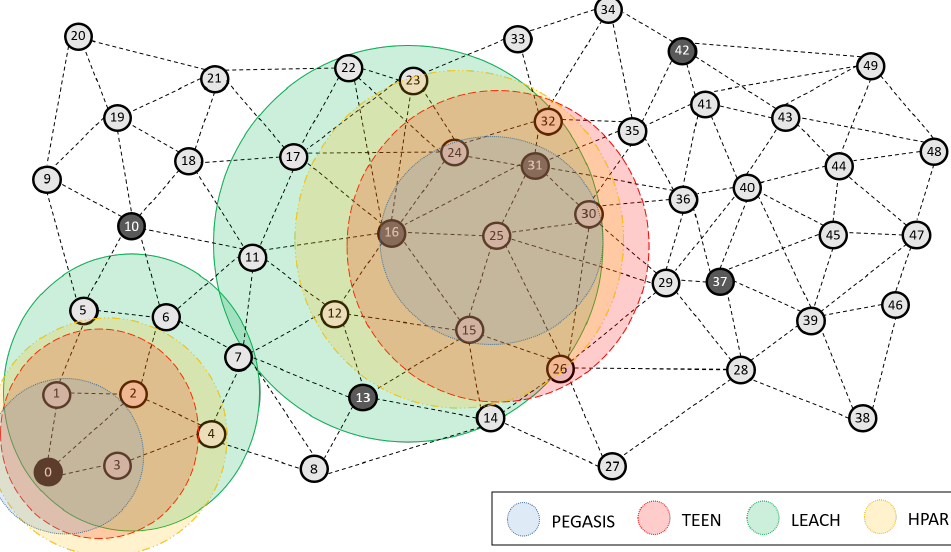
Figure 16. Algorithm for jamming detection under PEGASIS, TEEN, LEACH, and HPAR.